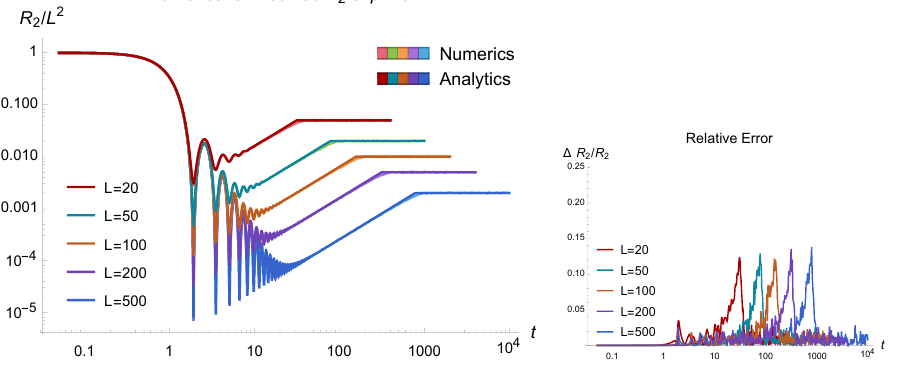
Figure 9 . The same numerics as reported in (cid:12)gure 8, but now compared to the analytic expression with the modi(cid:12)ed ramp behavior ~ r 2 ( t